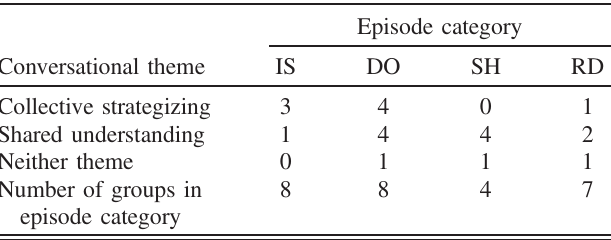
TABLE III. Clusters. Shown are the numbers of groups whose dialogue yielded at least one cluster, by